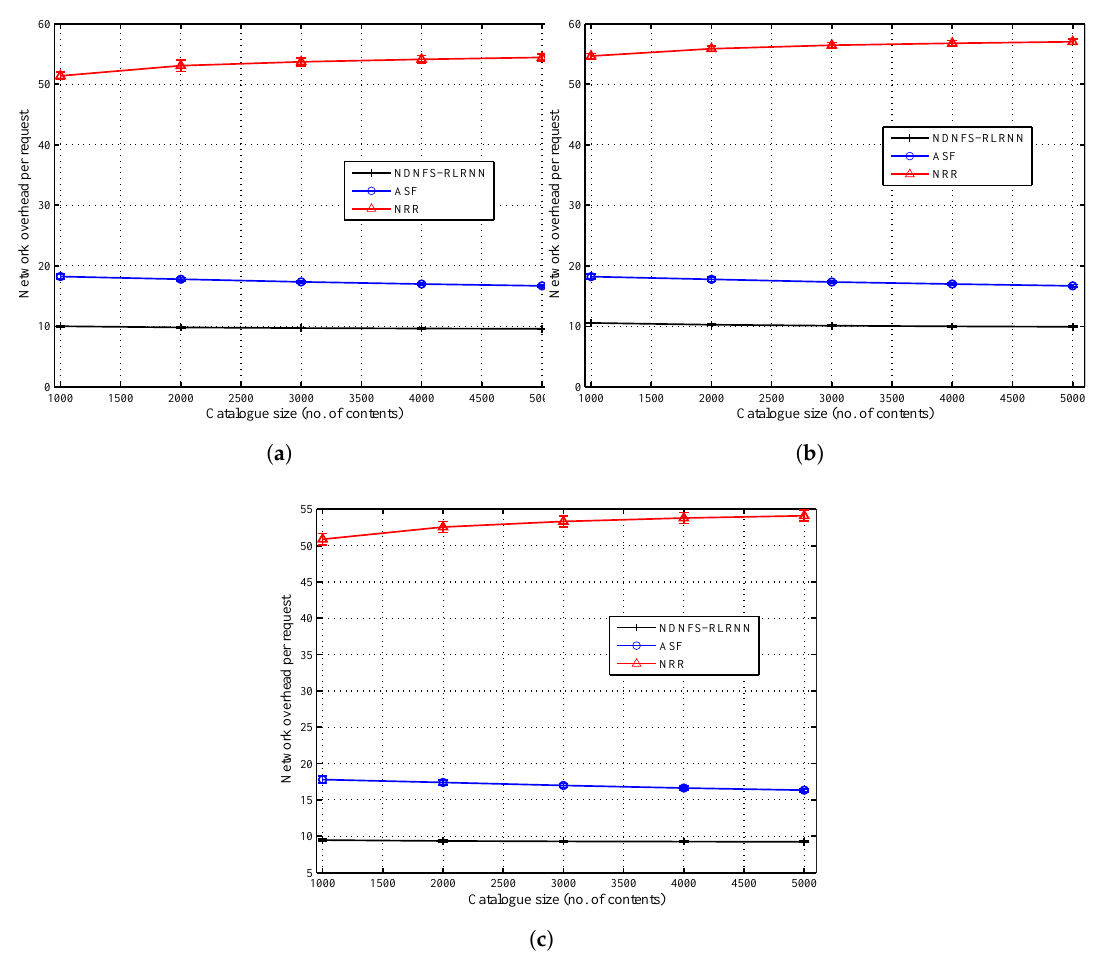
Figure 5. Network load performance of NDNFS-RLRNN ( p = 0.3), ASF and NRR for different